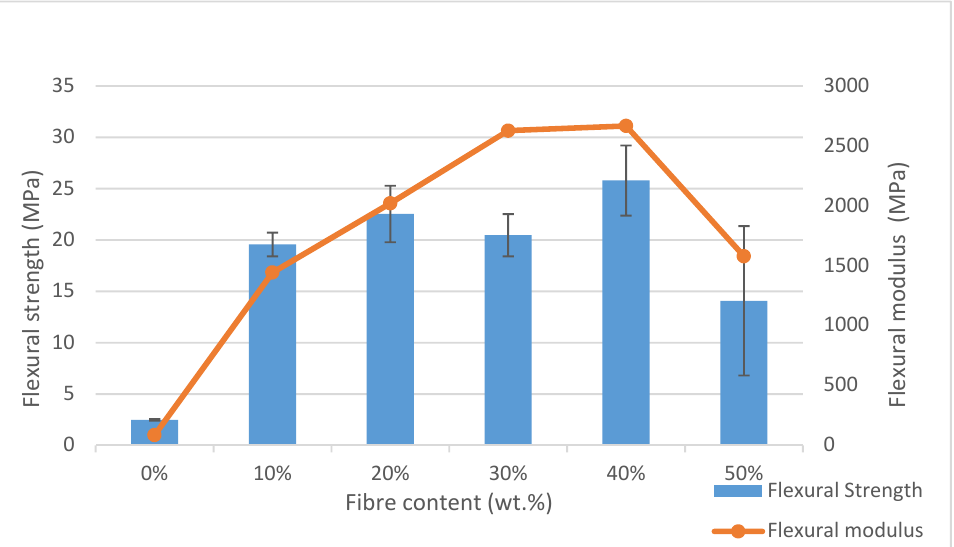
Figure 5. Elongation at break of TPCS/BLF composites.